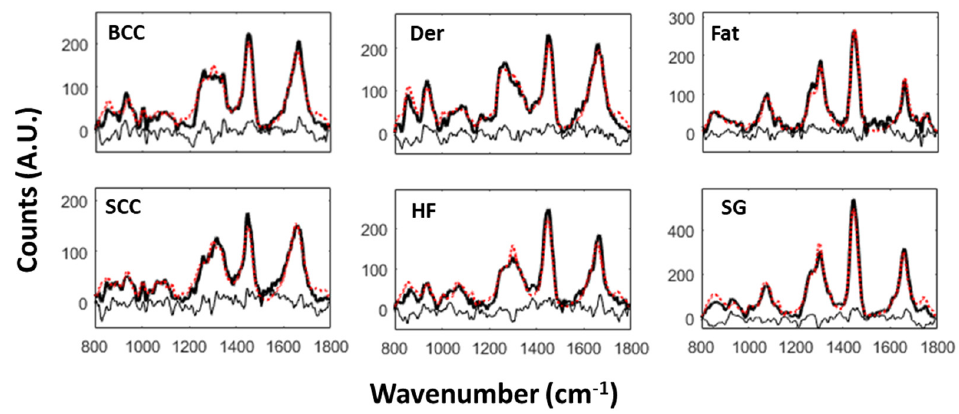
Figure 2. Examples of fitting of Raman spectra of skin samples that are dominant with BCC tumor, dermis (Der), Fat, SCC tumor, hair follicles (HF), and sebaceous glands (SG). Black bold solid lines represent Raman signal from skin samples, red dotted lines show model fitting, and black lines at the bottom are residuals from fitting.